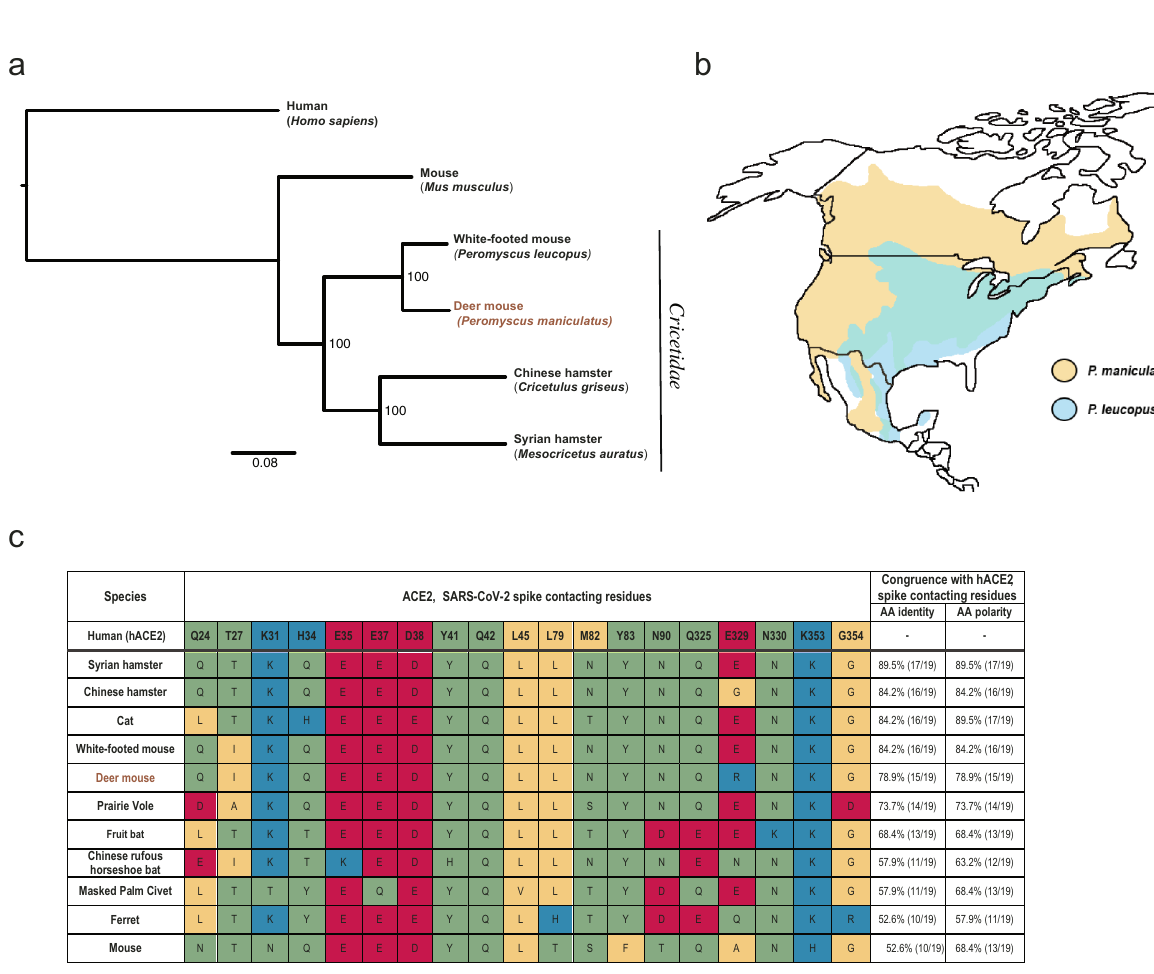
(Fig. 4f) and compared with uninfected controls ( n = 6). TNF α